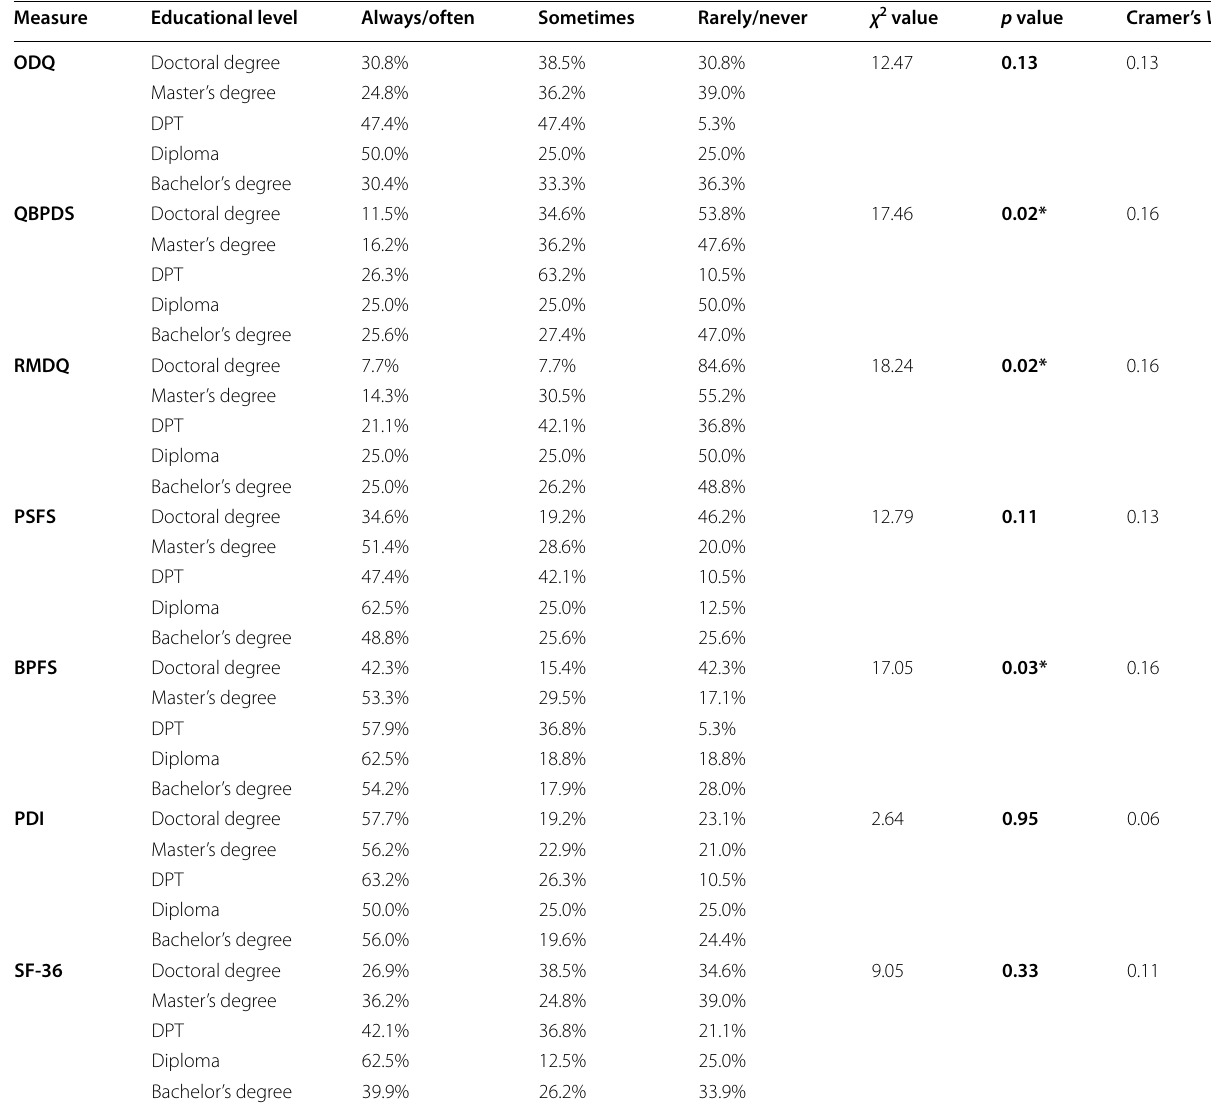
Table 4 Association of the use of functional outcome measure with educational level